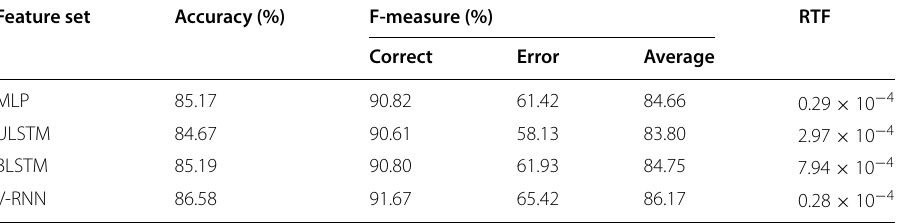
Table 3 Classification accuracies, F-measures and RTF of error detection obtained with the four models trained using the best feature set Feature